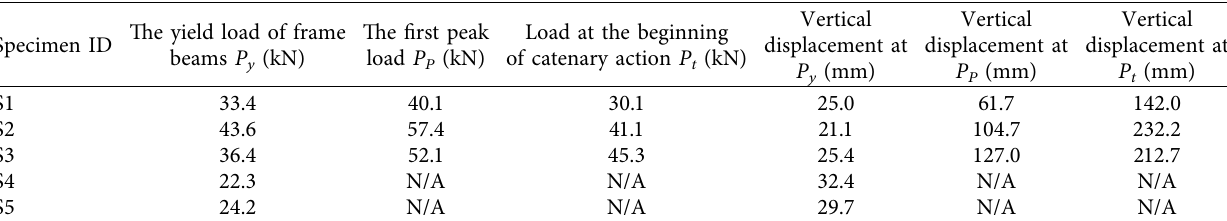
Figure 6: Relationship between vertical load and displacement. (a) Influence of prestress. (b) Influence of span-to-depth ratios of the frame beams. Table 3: Experimental